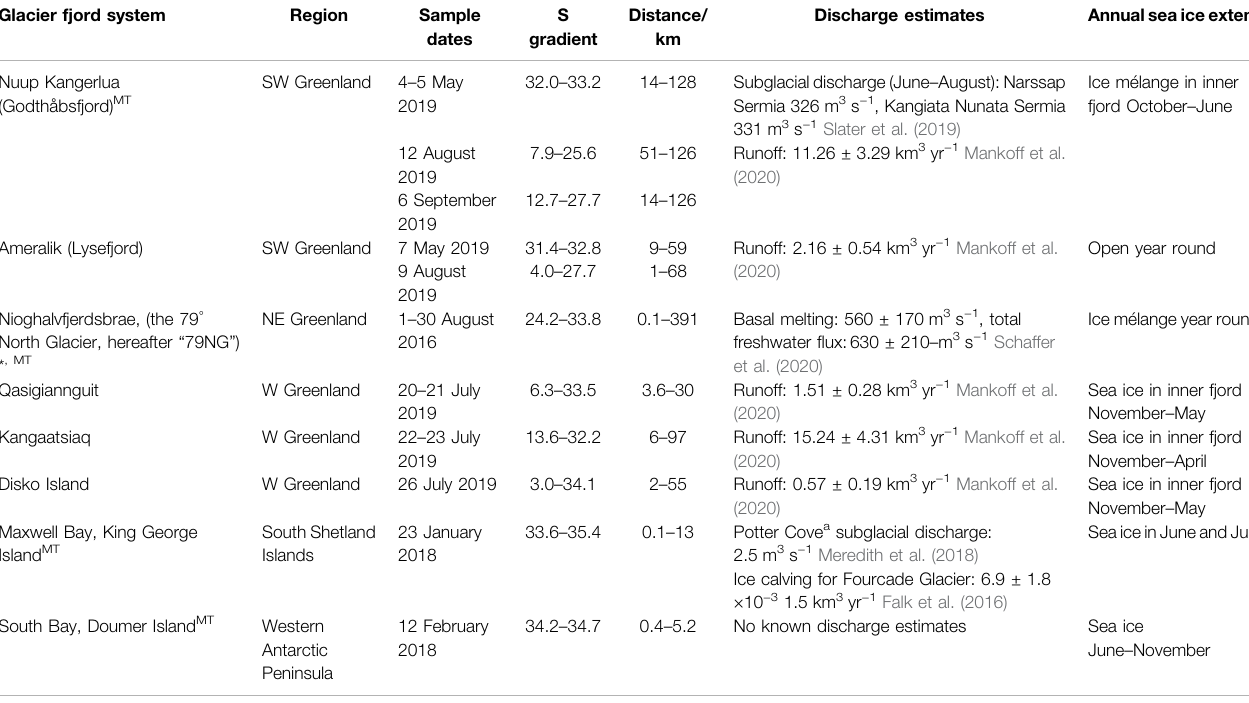
TABLE 1 | Sample collection details for glacier fjord transects. Salinity (S) gradient refers to surface ( < 10 m depth) waters. The section length is shown as the approximate range of distances from the main glacier terminus/out fl ow along sampled transects. Glacier fjord